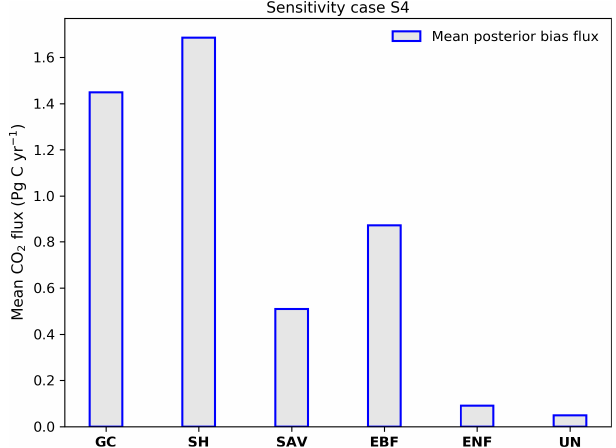
Figure 10. Posterior bias of monthly CO 2 flux induced by OCO-2 bias categorized by MODIS